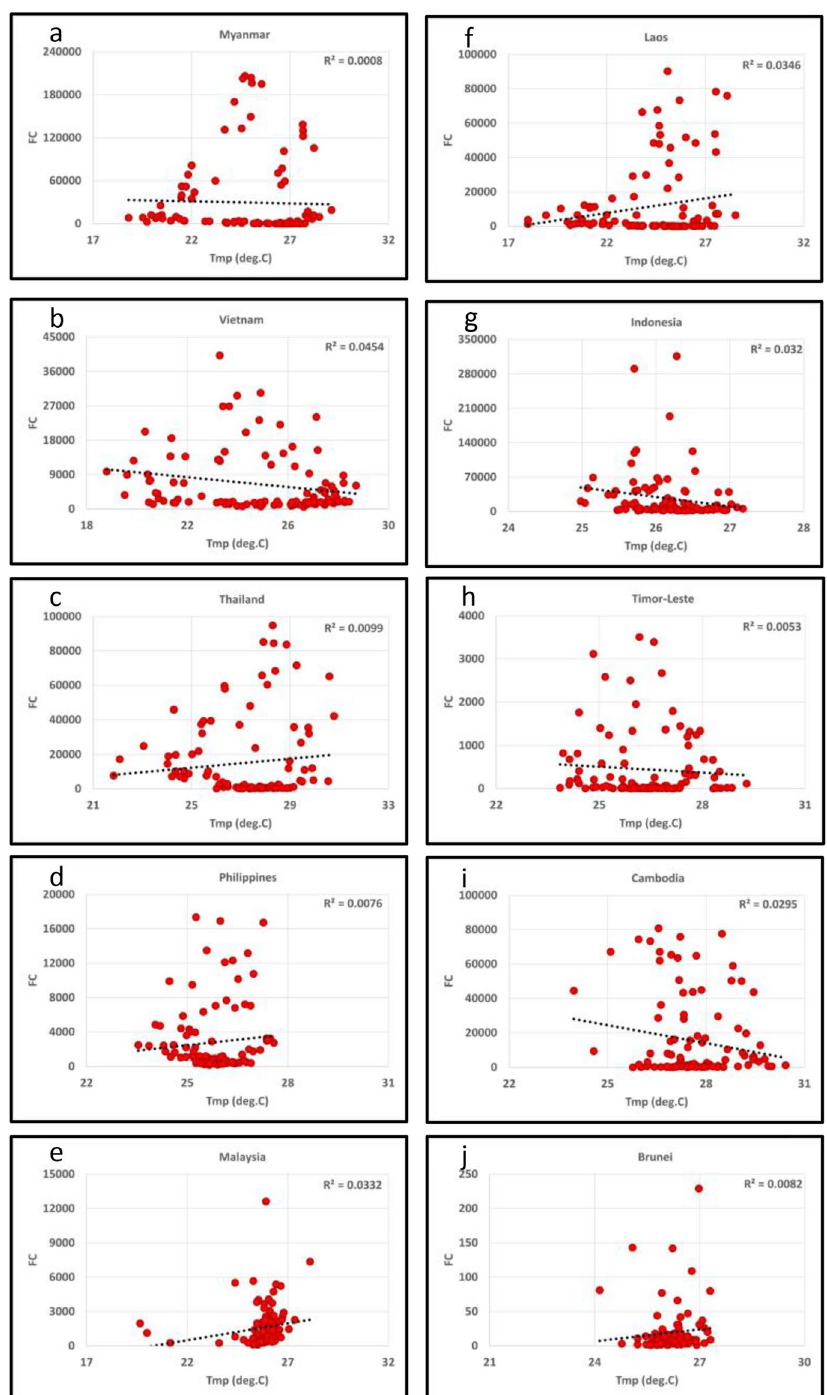
Figure 10. ( a )–( j ) Fire Counts (FC)-Temperature (Tmp) relationships in Southeast Asian countries. Most of the correlations were